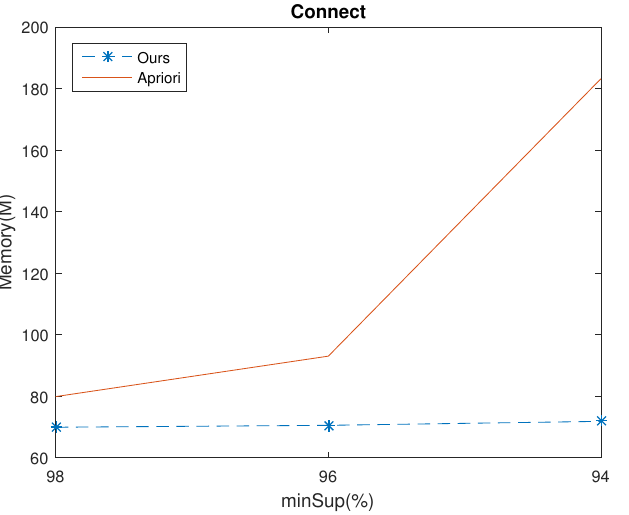
Figure 9. Memory usage of the two algorithms in Connect dataset for various minSup